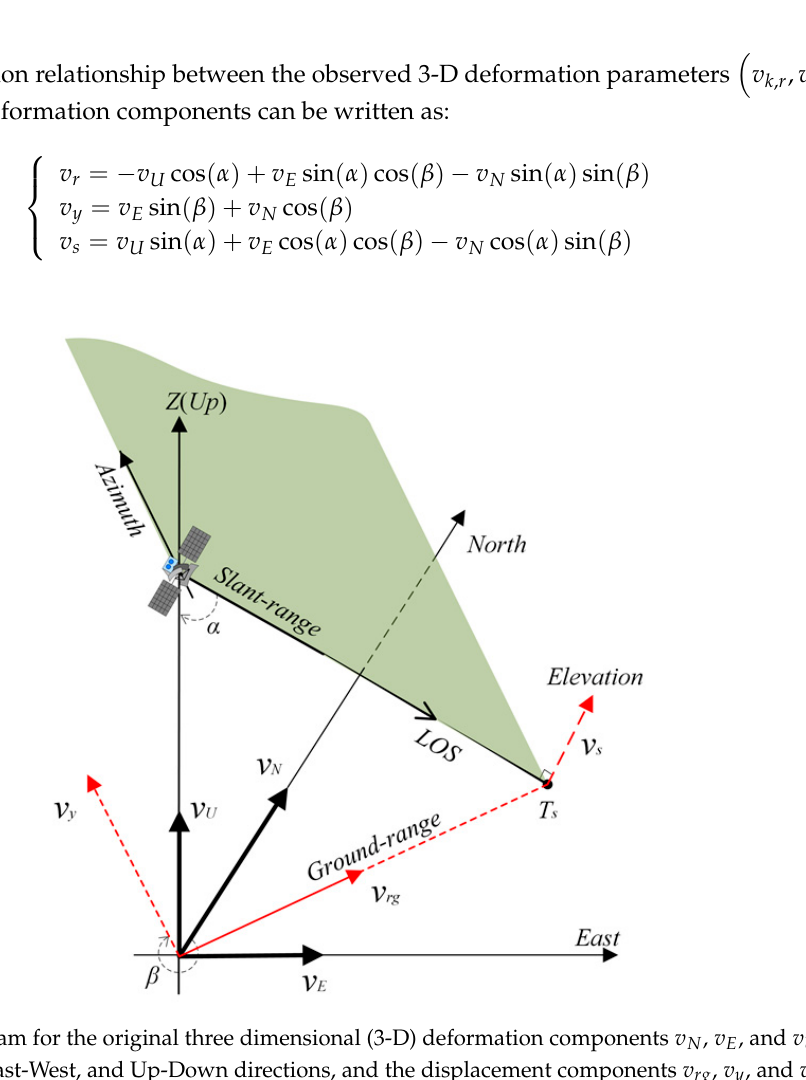
v , v , and N E v , rg